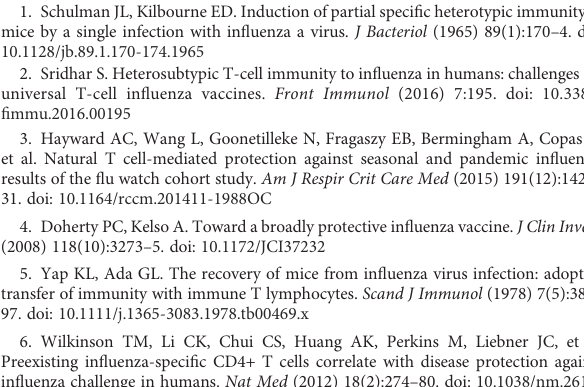
SUPPLEMENTARY FIGURE 1 Porcine B cells. (A) Gating strategy for porcine B-cell subsets. Lymphocytes were gated according to FSC-A/SSC-A properties and doublets and dead cells excluded (top panels). Lower panel: total B cells were identi fi ed by co- expression of CD79 a and Pax5 (blue gate) and further sub-gated. Plasma cells/plasmablasts were identi fi ed by the co-expression of Blimp-1 and IRF4 (green gate). Blimp-1 - IRF4 - B cells were gated (black gate) and further analyzed for Bcl-6 expression. CD79 a + Pax5 + Blimp-1 - IRF4 - Bcl-6 + cells were classi fi ed as GC B cells (red gate) and the remaining CD79 a + Pax5 + Blimp-1 - IRF4 - Bcl-6 - were considered as a mixture of naïve, activated, and memory B cells (purple gate). (B) Frequencies of total B cells, plasma cells, and GC B cells. Top left: CD79 a + Pax5 + total B cells were quanti fi ed within total live lymphocytes across organs and treatment groups. Lower left and lower right: as above but CD79 a + Pax5 + Blimp- 1 + IRF4 + plasma cells and CD79 a + Pax5 + Blimp-1 - IRF4 - Bcl-6 + GC B cells, respectively, within total B cells. Each symbol represents data from an individual pig of the different treatment groups. Asterisks indicate signi fi cant differences between treatment groups within one location (*, p ≤ 0.05) SUPPLEMENTARY FIGURE 2 Phenotypeofporcineantigen-speci fi cCD8 b + Tcellsintissues. (A) Expression of CD45RA and CCR7 by CD8 b + T cells isolated from the indicated tissues of control Babraham pig. (B) CD45RA and CCR7 expression in DFE-speci fi c CD8 b + T cells. Depicted are mean frequencies (± SEM) of naïve (CD45RA + CCR7 + ), TCM (CD45RA - CCR7 + ), TDE (CD45RA + CCR7 - ), and TEM (CD45RA - CCR7 - ) of fi ve or three (control) pigs per group (n=3-5). Statistical signi fi cances were analyzed by two-way ANOVA followed by Tukey ’ s Multiple Comparison Test. SUPPLEMENTARY FIGURE 3 Serum IgG responses against recombinant H1, H3, H5, and H7 at postmortem four days post H3N2 challenge at 1:80 dilution of serum. Each symbol represents one animal. Error bars represent mean ± SEM of pigs per group